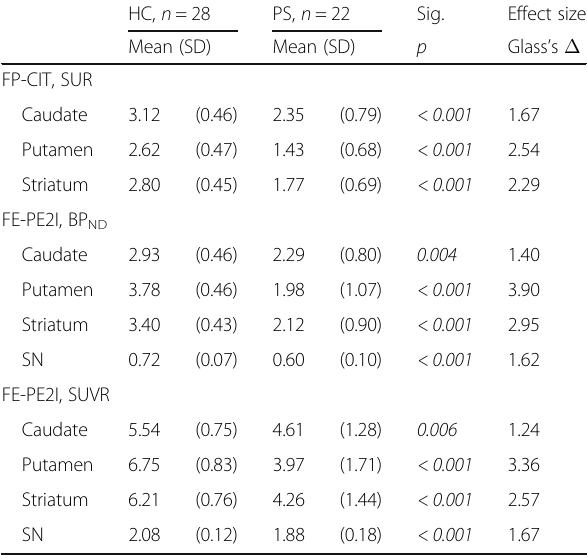
Table 3 Mean FP-CIT SPECT and FE-PE2I PET binding in HC